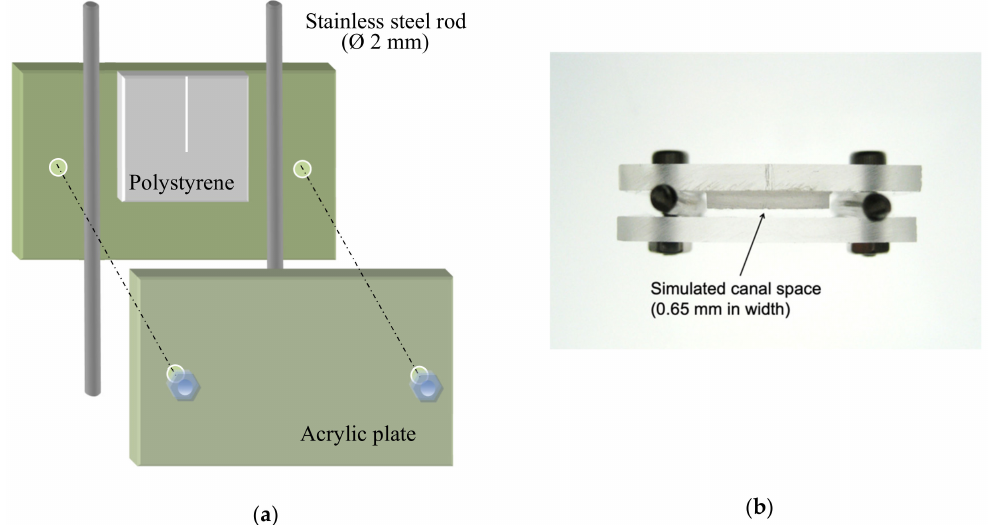
Figure 1. Artificial model simulating a canal with oblong cross section, akin to a wide isthmus: ( a ) Diagrammatic representation of the setup; ( b ) Top view of the actual model.